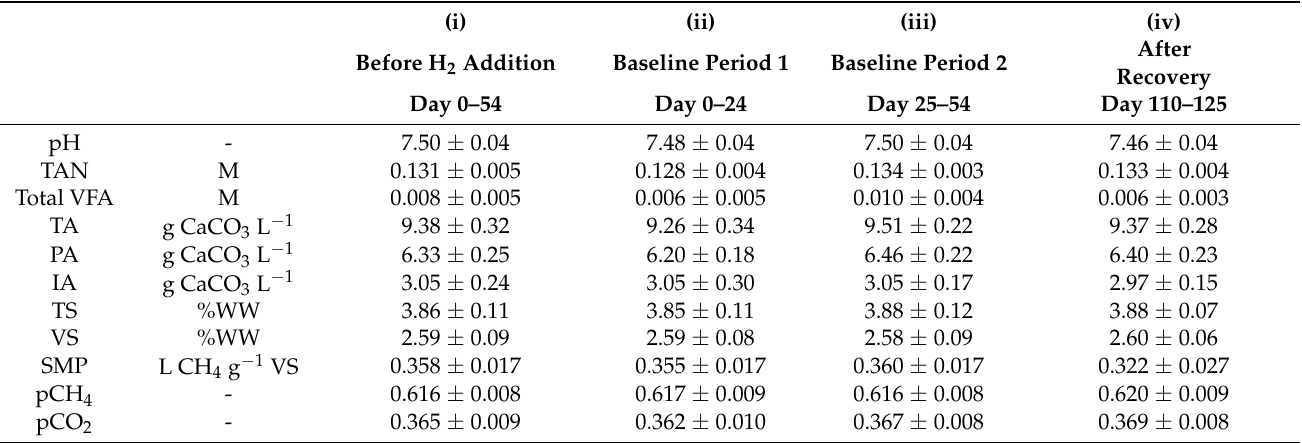
Figure 3. Values for ( a ) biogas CO 2 content, ( b ) pH, ( c ) total VFA, and ( d ) SMP in digesters D1 − 8 during the whole experimental period. Vertical dotted lines indicate the start of H 2 addition on day 55 and the re-establishment of full OLR in all digesters on day 87. Table 4. Average values of monitoring parameters in D1-8 from different periods of stable operation during the experimental